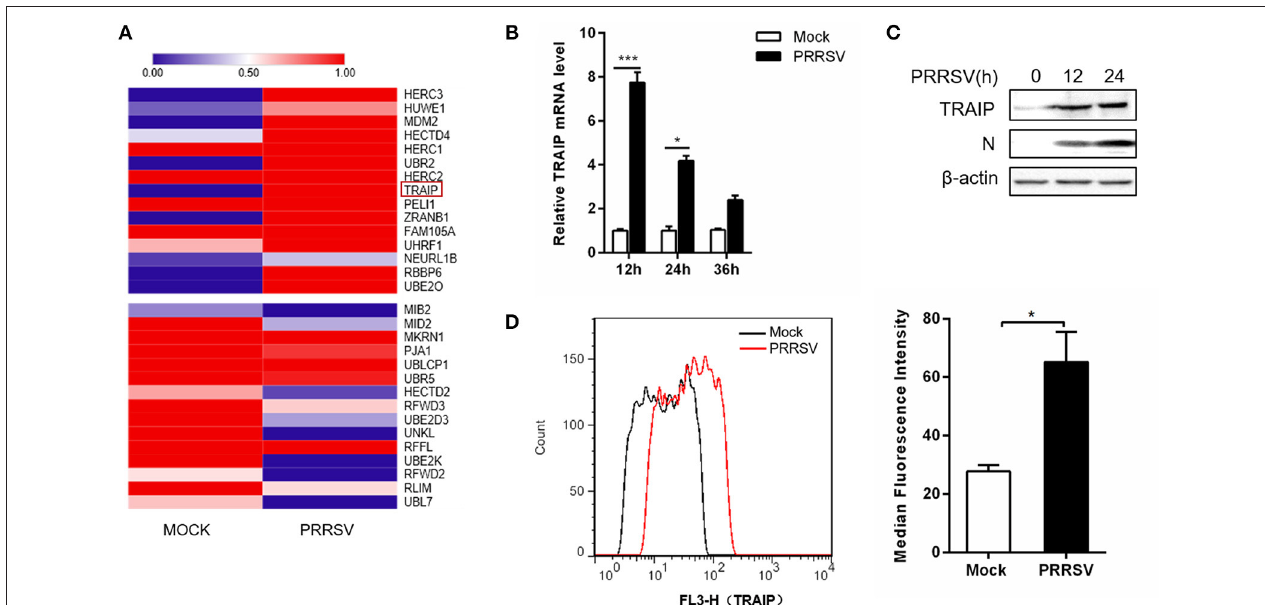
FIGURE 1 | TRAIP is upregulated in 3D4/21 by PRRSV. (A) The heatmap of ubiquitin-related differentially expressed genes analyses were generated using online websites (https://software.broadinstitute.org/morpheus/). Red bars indicate an upregulation in expression of at least 1x fold. (B) qRT-PCR analysis of TRAIP in 3D4/21 inoculated without or with 0.5 MOI PRRSV at the indicated times. (C) 3D4/21 were either mock-infected or infected with PRRSV at a 0.5 MOI for 12 or 24h. The cells were then harvested to detect TRAIP by Western blotting using a mouse anti-TRAIP polyclonal antibody and cell lysates were then analyzed for expression of PRRSV structural protein (N) with anti-N MAb. (D) 3D4/21 cells were mock-infected or infected with 0.5 MOI PRRSV. Cells were collected at 12h post-infection. Analysis of TRAIP protein expression levels by flow cytometry. * P < 0.05, *** P < 0.001 (analysis of two-way ANOVA followed by Bonferroni post-test). Data are representative of three independent experiments.